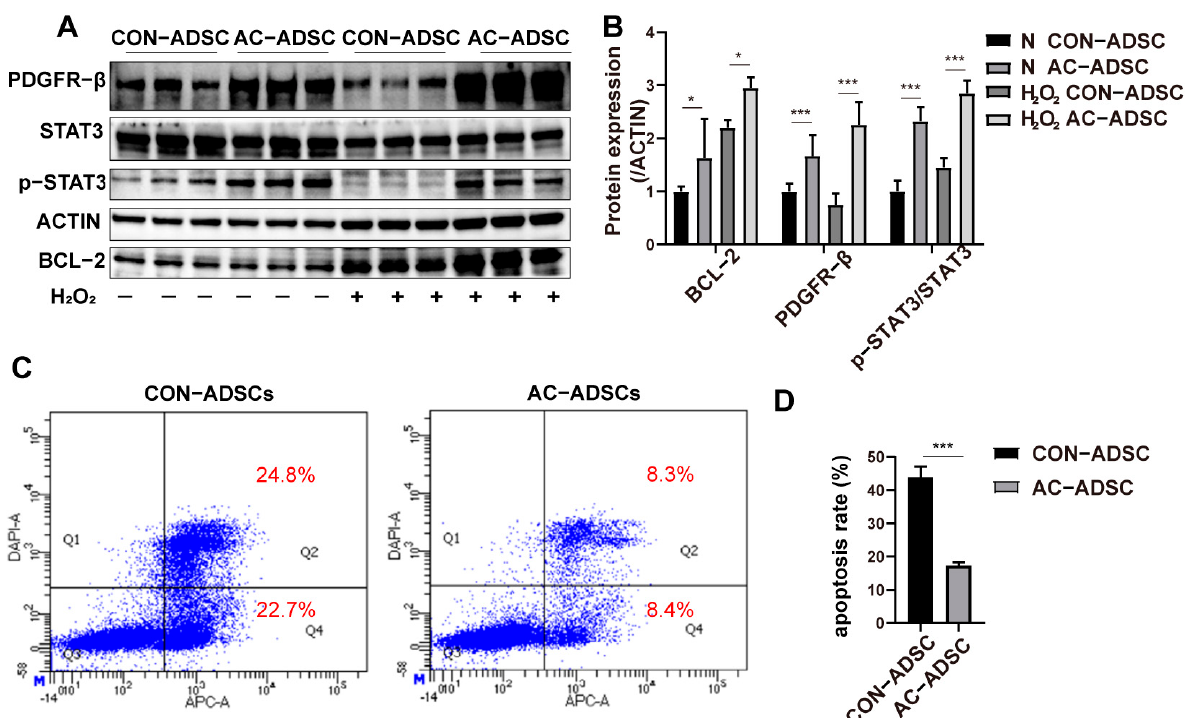
Figure 3. PDGFR −β overexpression enhances the resistance to oxidative stress of ADSCs. ( A ) Western blotting and ( B ) quantification analysis of H 2 O 2 treated ADSCs ( n = 3). ( C ) The apoptosis of ADSCs detected by flow cytometry and ( D ) quantification analysis ( n = 3). Data are shown as mean ± SD. Independent–sample t test (two–tailed) was used for statistical comparisons between 2 groups; One– way ANOVA followed by Tukey post hoc test was used for statistical comparisons between multiple groups. * p < 0.05; *** p <